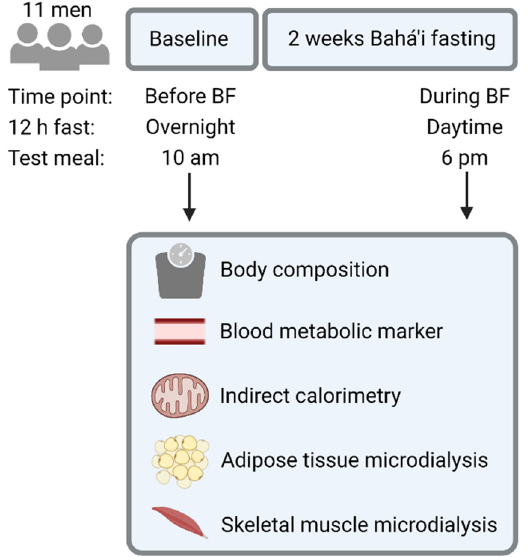
Figure 1. Study design of the self-controlled cohort study on Bahá’i fasting (BF). Figure created with BioRender.com (accessed on 27 December 2021).